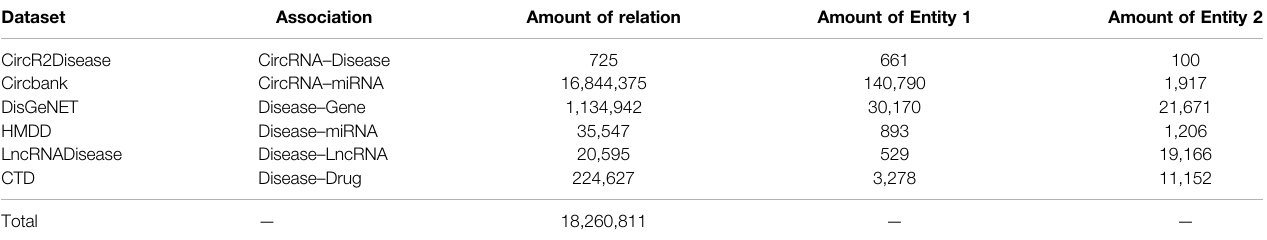
TABLE 1 | The number of different types of associations in SAAED.